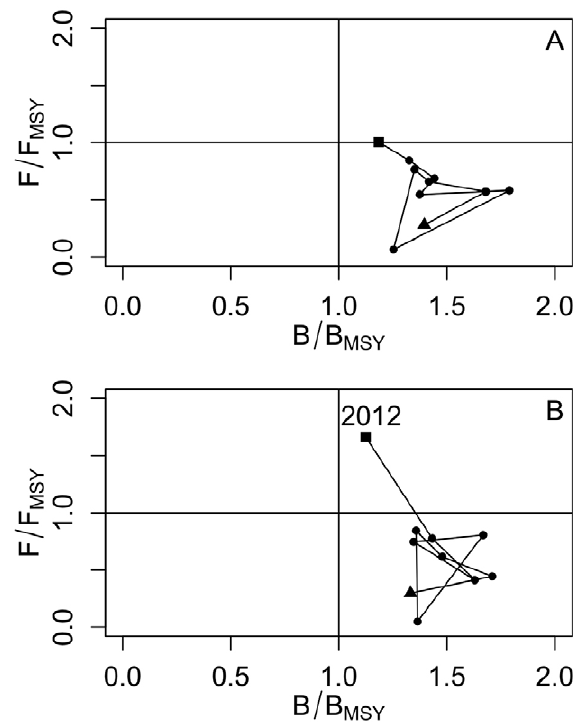
Fig. 6. – Development of the O. bartramii fishery from 2003 to 2013. A, based on the PS model; B, based on the Ps-EDSP model. Triangle represents the biomass status of the first year (2003) of study; square represents the biomass status of the last year (2013).